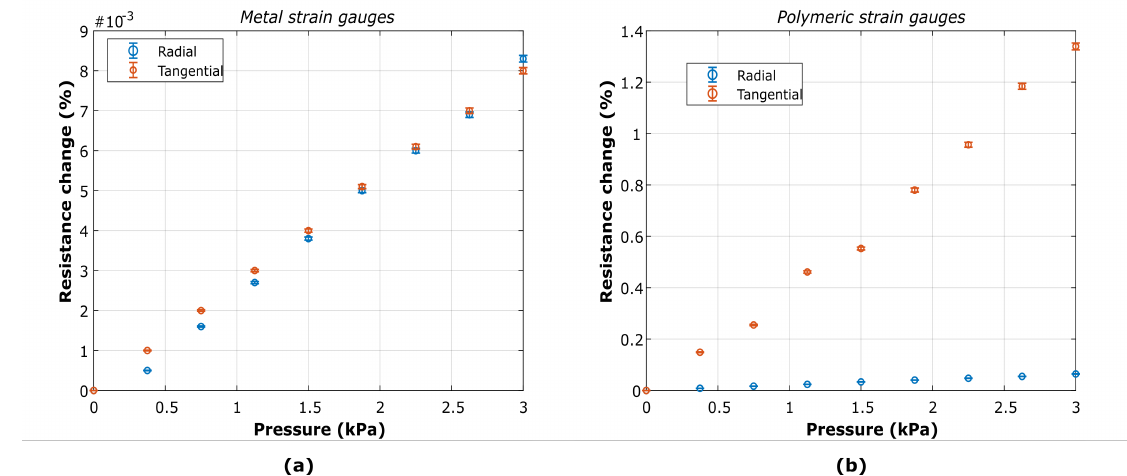
Figure 8. Stationary measurements of resistance change for radial and tangential strain gauges made of ( a ) titanium (Ti) and ( b ) PEDOT:PSS. Error bar: